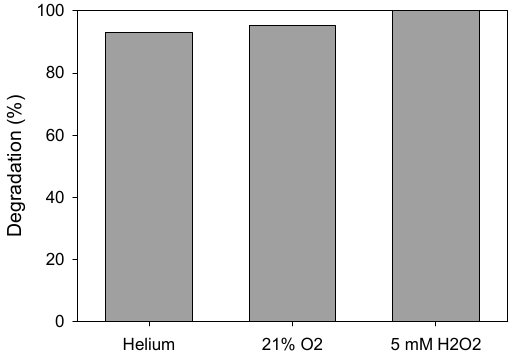
Figure 13. ATL degradation (%) with and without oxidizing agents. Initial ATL concentration: 10 ppm; AgCl concentration: 10 ppm.